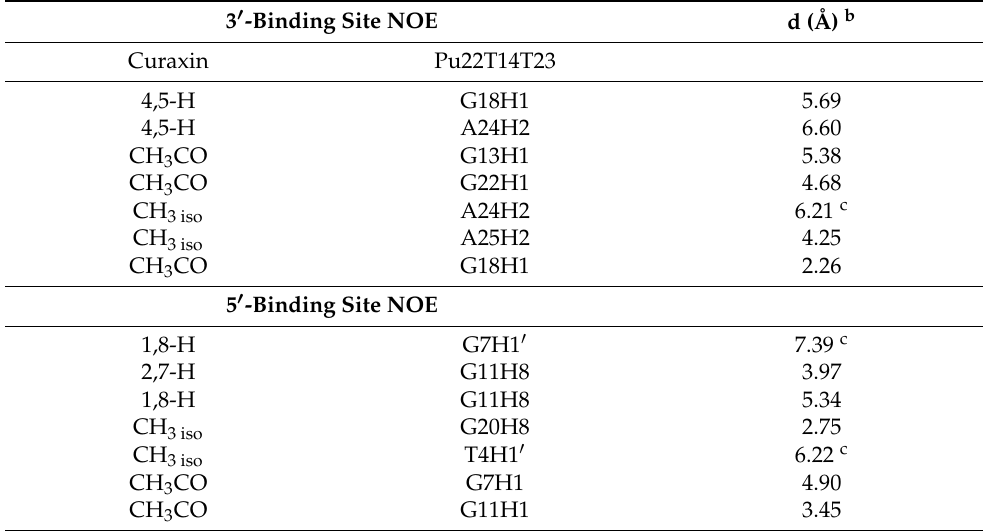
Table 2. Intermolecular NOEs and distances from modelling in the curaxin-Pu22T14T23 a complex. 3 (cid:48) -Binding Site